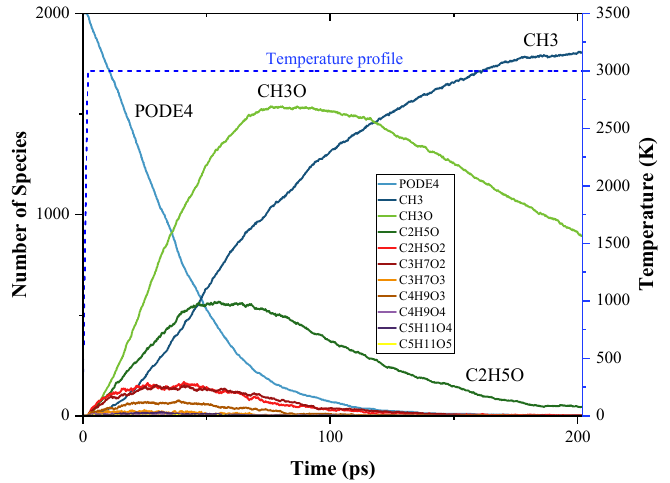
Figure 6. Time evolution of PODE4 and the products from the initial decomposition during the simulation of PODE4 pyrolysis using ReaxFF MD; temperature profile of MD simulation.